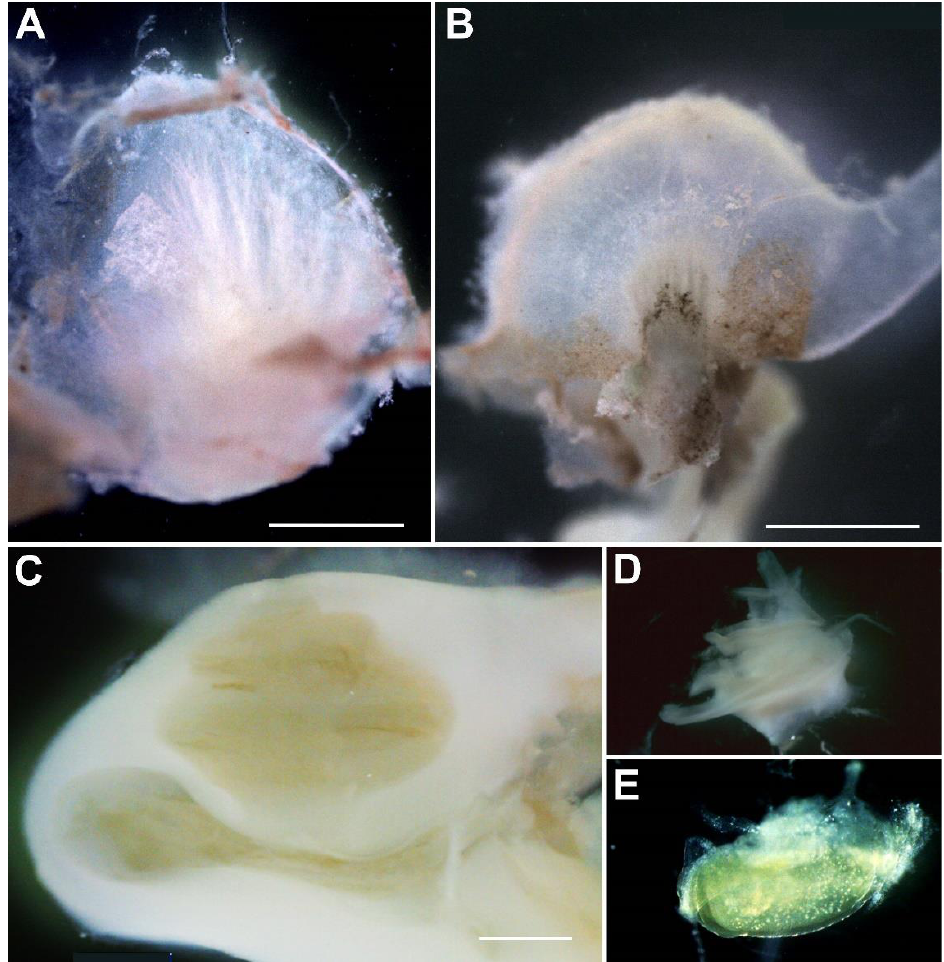
Figure 2. Human adult and fetal dissected inner ears. ( A ) Adult utricle. ( B ) Adult ampulla. ( C ) Fetal cochlea, W14. ( D ) The otic capsule was removed to expose the modiolus and organ of Corti. ( E ) Fetal saccule, W14. Scale bars: 1 mm.